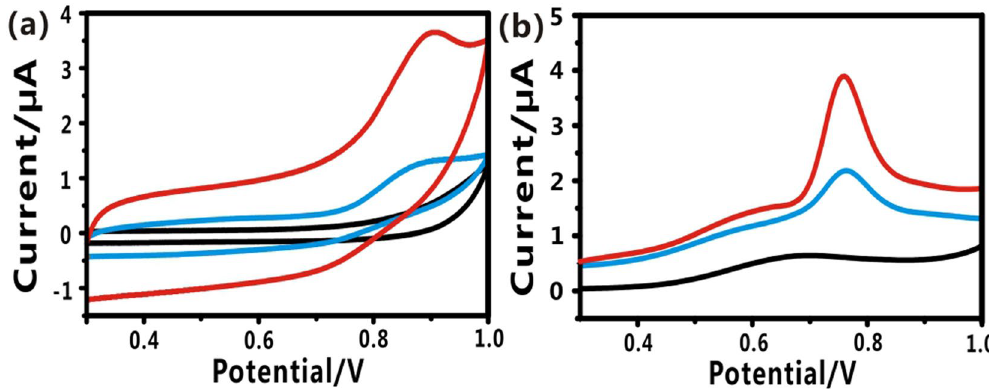
Figure 2. Electrochemical signals ( a ) CVs and ( b ) DPVs obtained at the different nanomaterials-modified acupuncture needle: bare AN (black line), Au/AN (blue line), FGPC/AN (red line) in deaerated PBS solution consisting of 18 μ M NO.